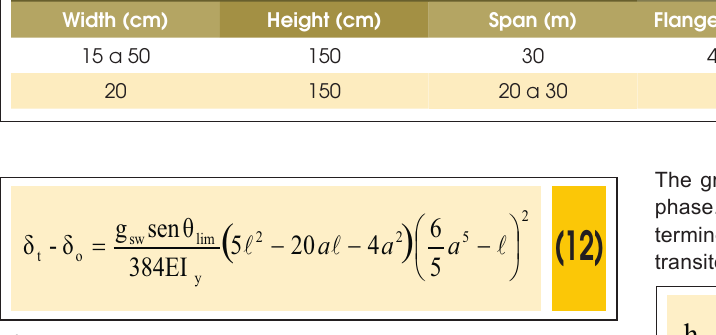
Table 3 – Geometric properties of analyzed precast elements Rectangular